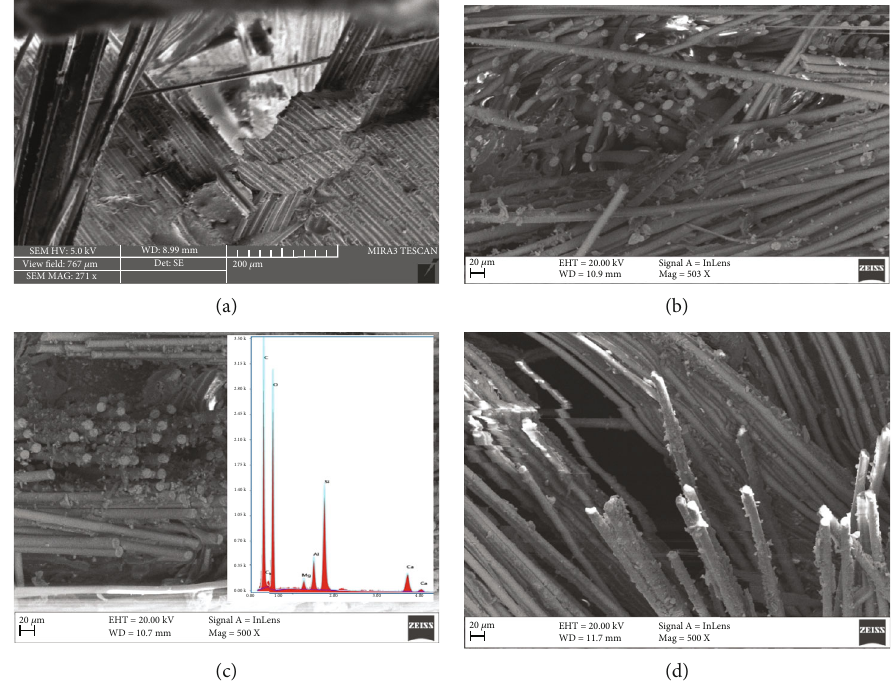
Figure 6: Fracture surface of composite with (a, b) 0wt.% fi ller, (c) 0.2wt.% of r-GO, and (d) 0.3wt.% of r-GO.